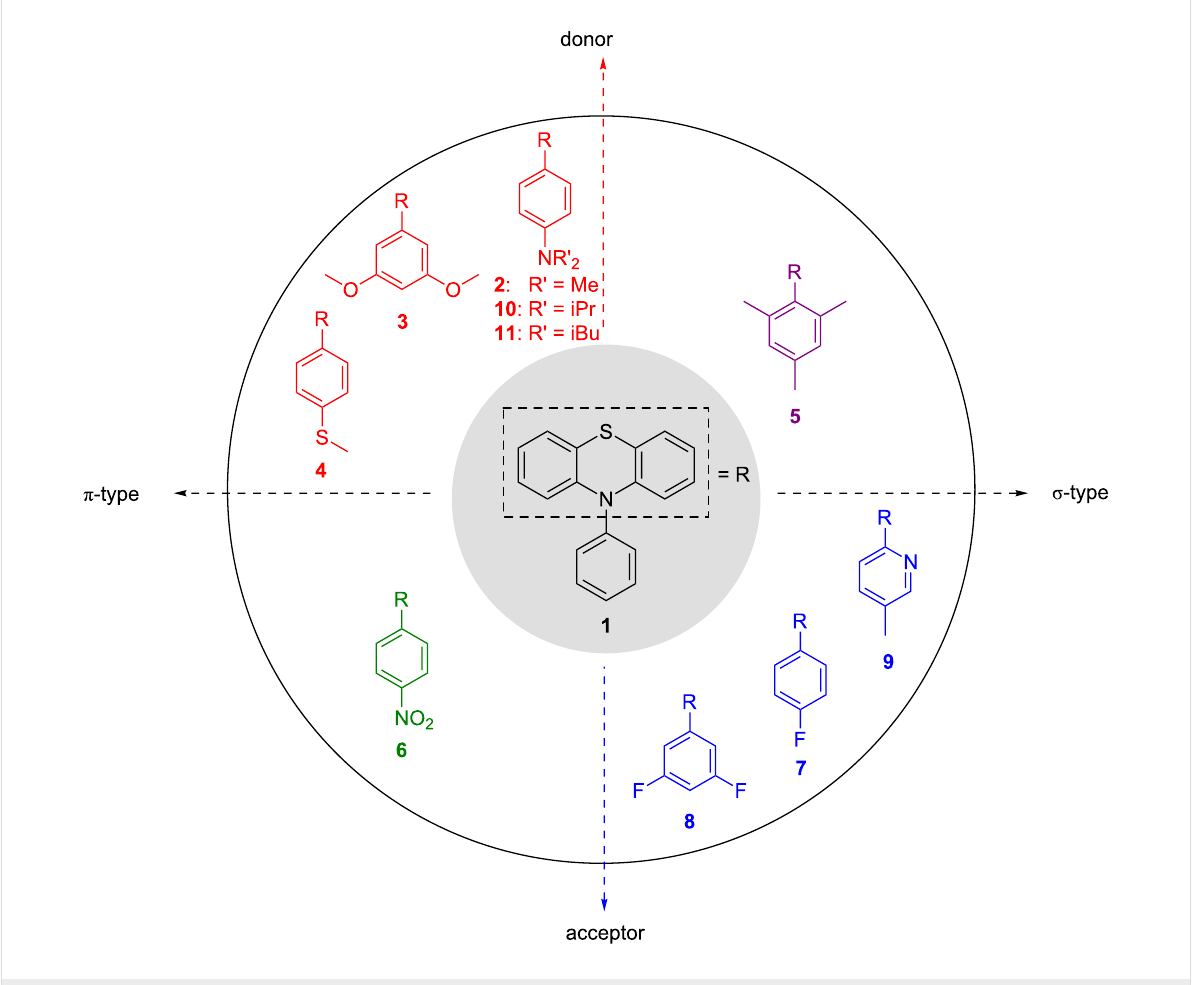
Figure 2: Acceptor or donor-modified phenothiazines 1 – 11 as potential photoredox catalysts.